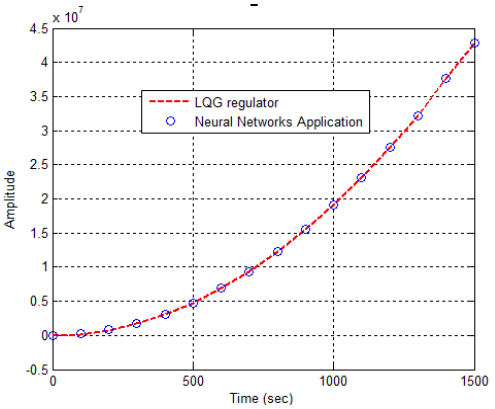
Figure 8. Step Response of the Open Form ‘G(S)’